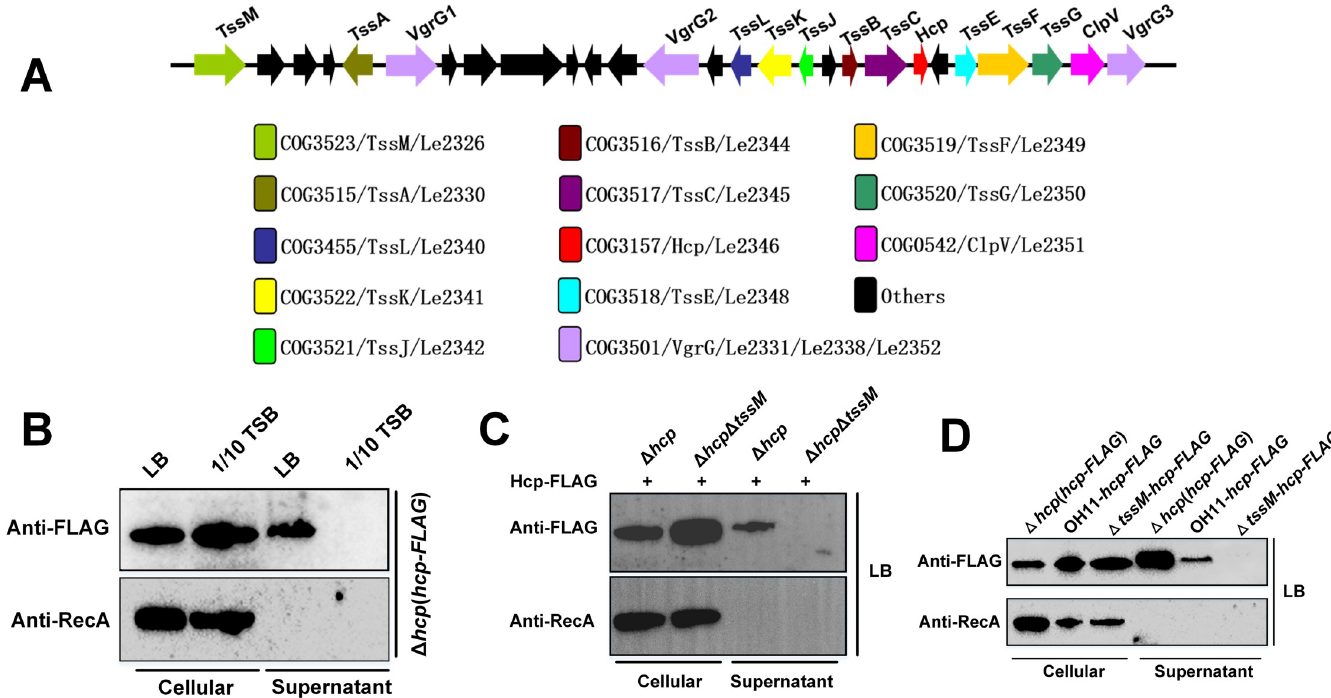
Fig 1. A functional T6SS system is assembled in L . enzymogenes grown in rich medium. (A) The L . enzymogenes T6SS gene cluster. The genes encoding T6SS components, identified with the help of the database of Clusters of Orthologous Groups of proteins (COGs) [25, 40], are shown in color. (B) Western blot showing that Hcp is secreted by the Δ hcp mutant expressing the plasmid-borne Hcp-FLAG, when the strain is grown in rich (LB) but not nutrient-poor (1/10 TSB) medium. The housekeeping protein RecA was used as intracellular control. (C) Western blot revealing that the tssM deletion blocks the secretion of the plasmid-expressed Hcp-FLAG in the strains grown in LB. (D) Western blot showing that the tssM deletion impairs the secretion of the chromosomally expressed Hcp-FLAG. The assays were repeated three times with similar results. OH11, wild-type strain; Δ hcp , the hcp deletion mutant; Δ hcp Δ tssM , the tssM and hcp double mutant; ( hcp-FLAG ), the plasmid-borne hcp-FLAG gene expressed from the native hcp promoter; OH11- hcp-FLAG , the OH11 derivative strain, in which the chromosomal hcp gene was replaced with the hcp- FLAG allele; Δ tssM - hcp-FLAG , the Δ tssM mutant, in which the chromosomal hcp gene was replaced with the hcp-FLAG . Anti-FLAG, monoclonal antibody against FLAG; Anti-RecA, monoclonal antibody against RecA.